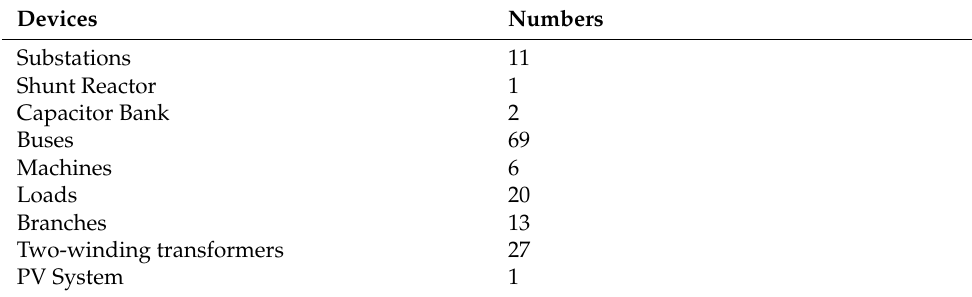
Table 1. Number of components in system model.